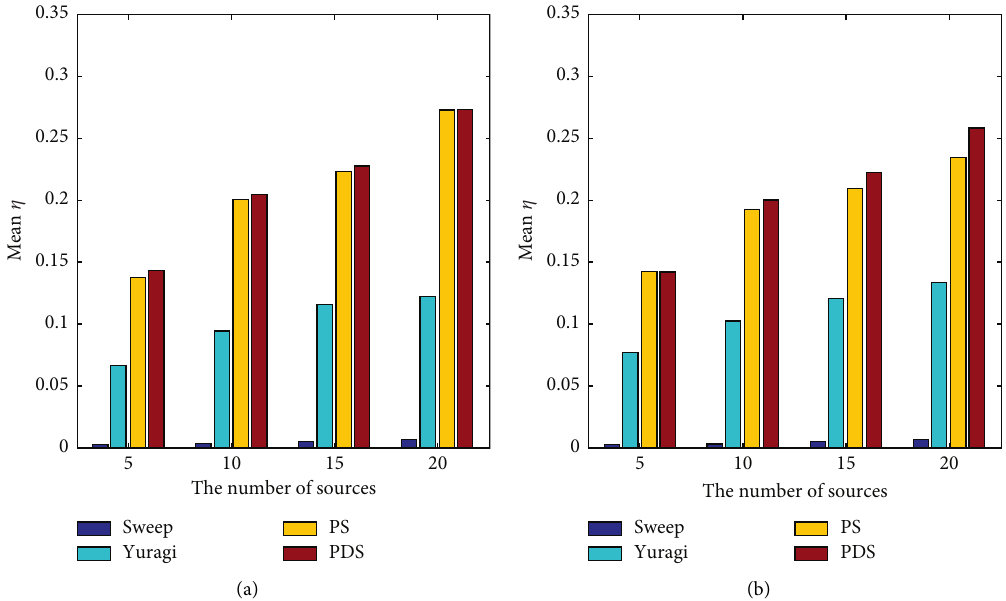
Figure 11: For the same central field intensity, comparison of η for four algorithms. Blue, cyan, yellow, and red bars represent η for the sweep, Yuragi, PS, and PDS, respectively. (a) The sources with the Gaussian-like shape field intensity distribution. (b) The light